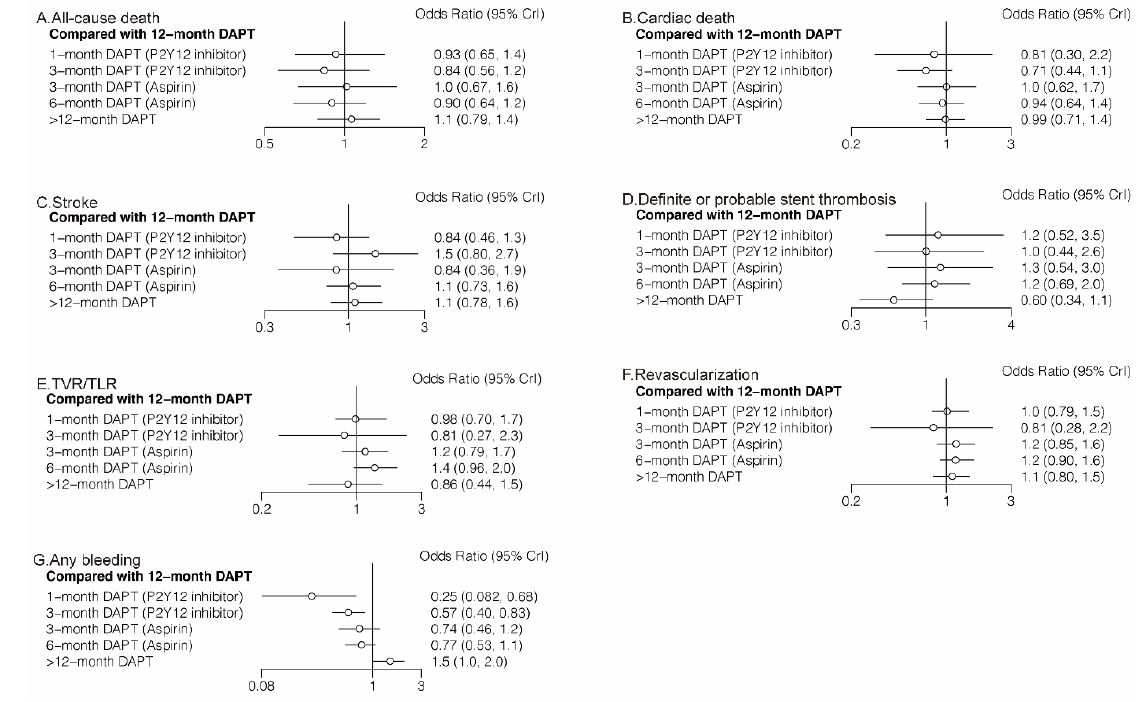
Figure 4. Network Meta-Analysis for Secondary Outcomes.